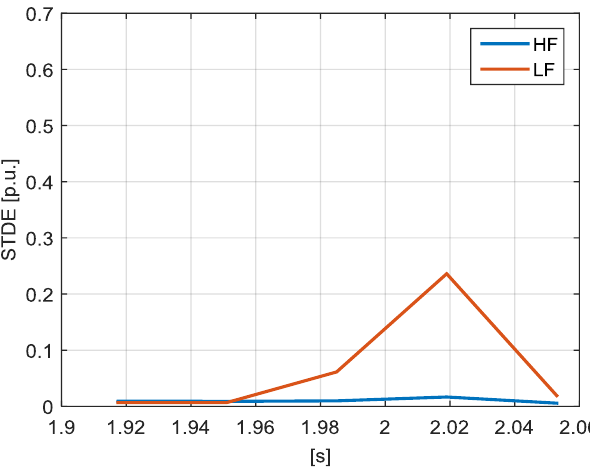
Figure 37. Case study 3: STDE at low-frequency (0 ÷ 2.4 kHz, red line) and at high-frequency (2.4 ÷ 150 kHz, blue line) obtained through STFT.